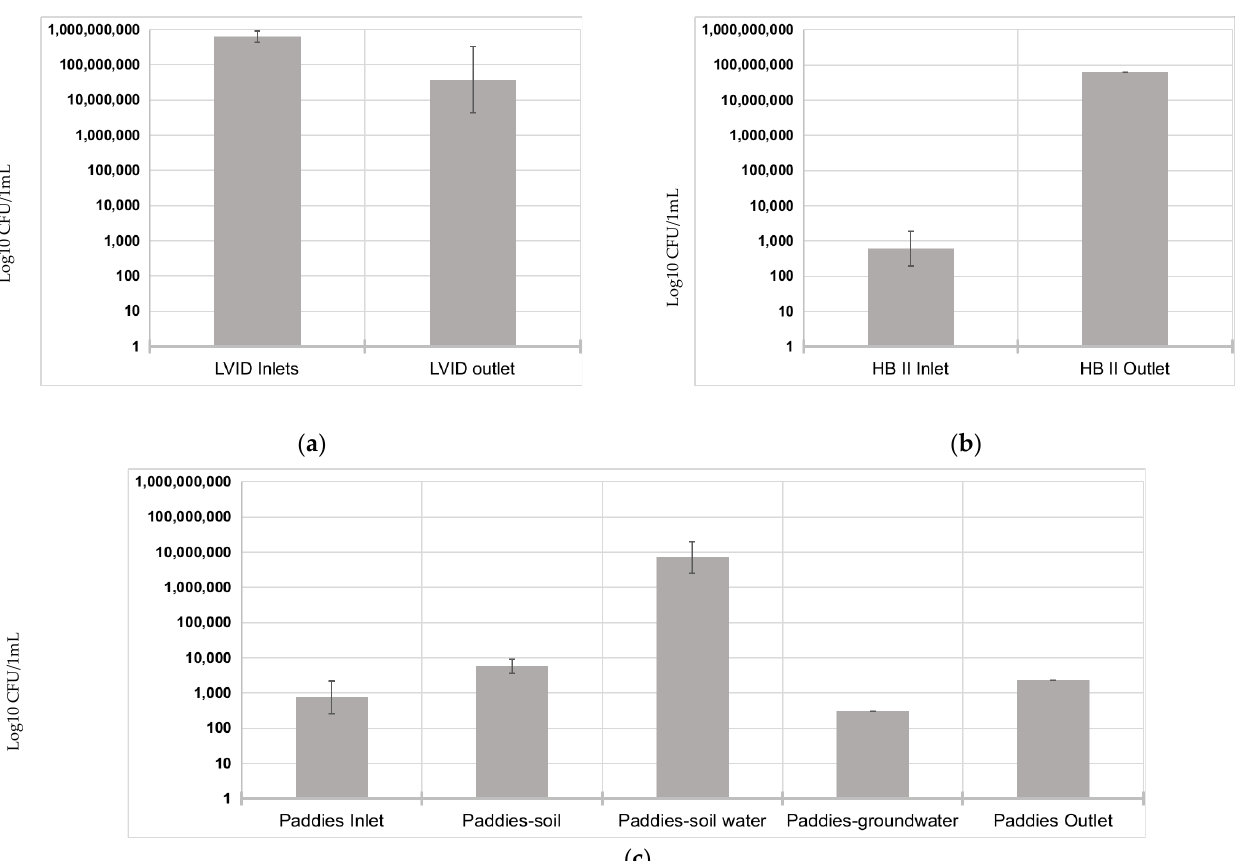
Figure 3. Mean values of Enterobacteriaceae Amp r counts, expressed in CFU/mL (and standard deviation) at the inlet and outlet of: ( a ) LVID; ( b ) Block II (HB II); ( c ) rice paddies of Block II, including at the soil, soil water and groundwater.